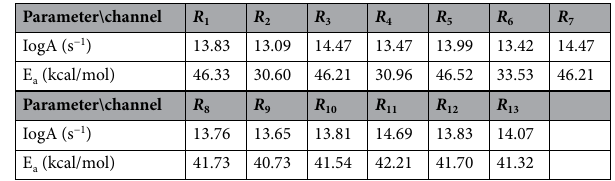
Table 3. Two-parameters Arrhenius coefficients for unimolecular decomposition reactions of the investigated ethoxyquinolines and ethoxyisoquinolines (R1–R13) from TST/Eck calculations ( T = 400–1200 K, p = 1 atm) using CBS-QB3 energies.